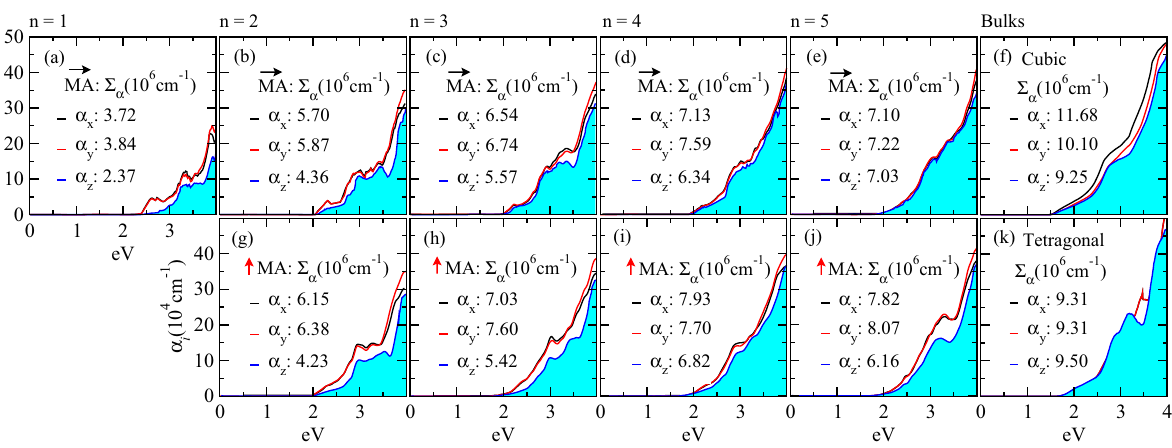
Figure 6. Absorption coefficients, α(ω) , calculated via DFT+D3+SOC-1/2 for all BA 2 MA n − 1 Pb n I 3 n + 1 2D-RP through the MA horizontal-like ( a )–( e ) and BA-MA aligned-like ( g )–( j ) configurations, given that x ( α x ), y ( α y ), and z ( α z ) directions were considered separately. α z is filled for all 2D-RP systems, as well as for the cubic ( f ) and tetragonal ( k ) bulks. Total absorbance ( (cid:31) α ) values are depicted for the 0.0–4.2 eV